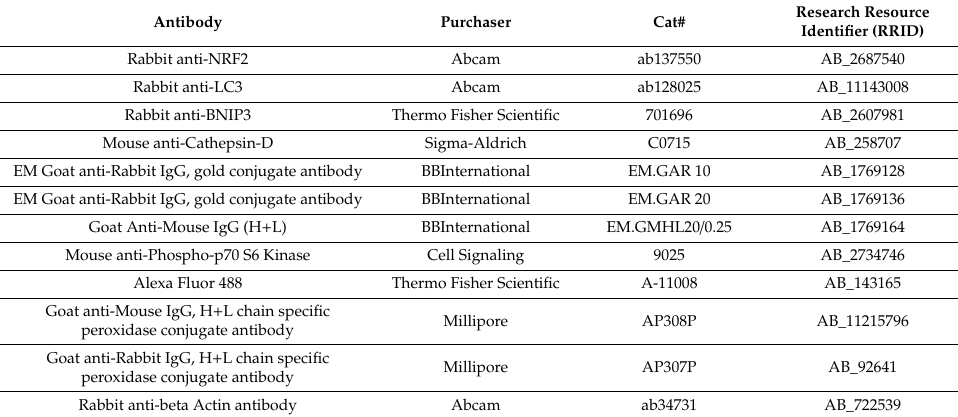
Table 2. Sources and identification codes for each antibody used in the present